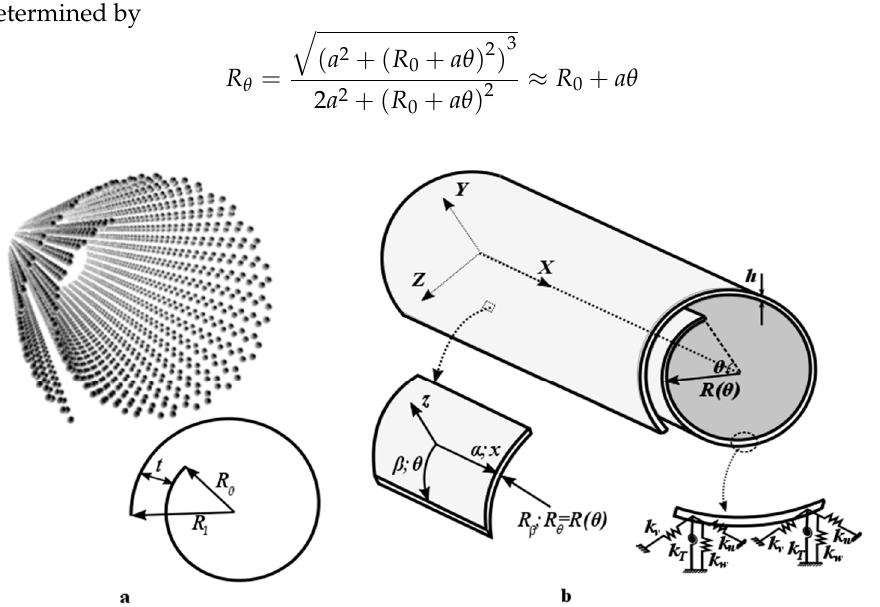
Figure 1. Geometry of a CNS: ( a ) atomistic model of CNS and its cross-section; ( b ) equivalent continuum shell model.